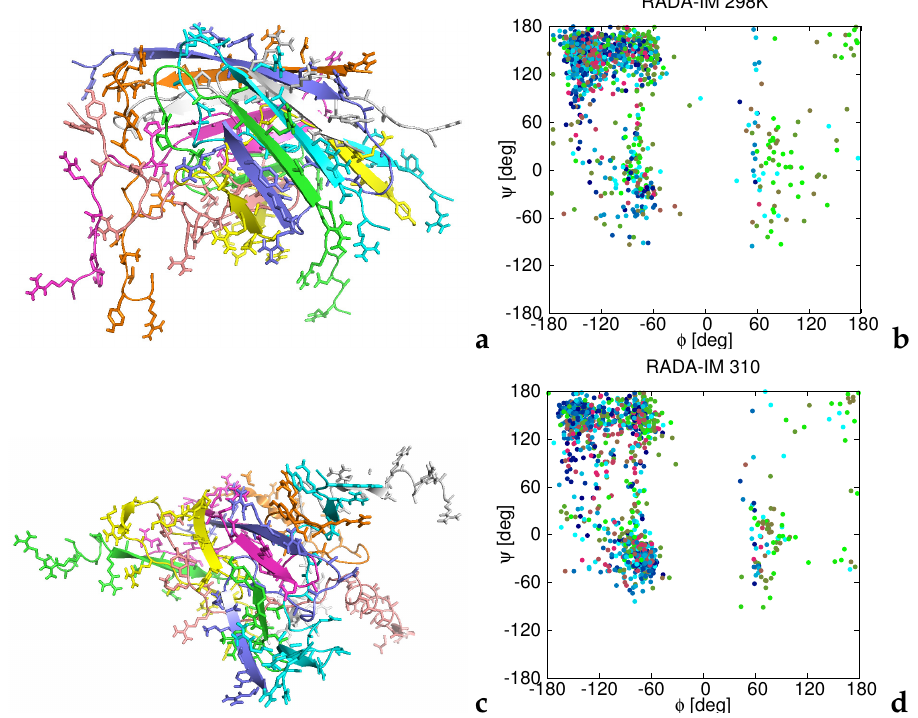
Figure 7. Representative structures of the octamers of RADA-IM at T = 298 K ( a ) and T = 310 K ( b ) obtained in MREMD simulations of eight-chain systems and the corresponding plots of the backbone φ and ψ angles collected from all five models obtained by the cluster analysis at these two temperatures ( b , d ). Each chain in panels a and c is colored by a different color. Backbones are represented as ribbons and the side chains are shown in the stick representation. The structures were obtained by converting the UNRES chains into the all-atom representation. Each point in the ( φ , ψ ) -plots is colored according to residue index (chain index ignored), from blue to red from the N- to the C-terminus. The drawings were produced with PyMol [64] and gnuplot [57],